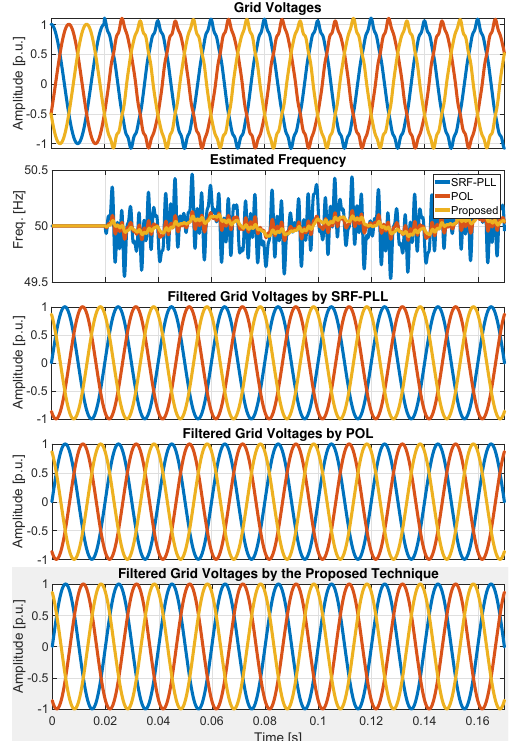
Figure 6. Comparative numerical simulation results for Test-III: Harmonics robustness test.